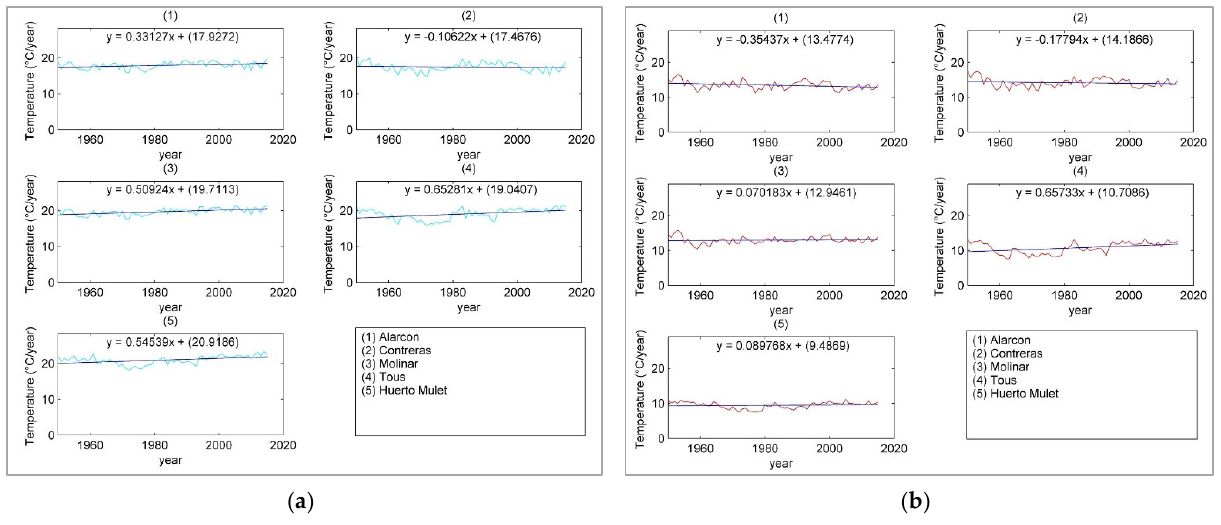
Figure A3. Interannual variation trends of the average ( a ) maximum temperature (°C) and ( b ) tem- perature range (°C).